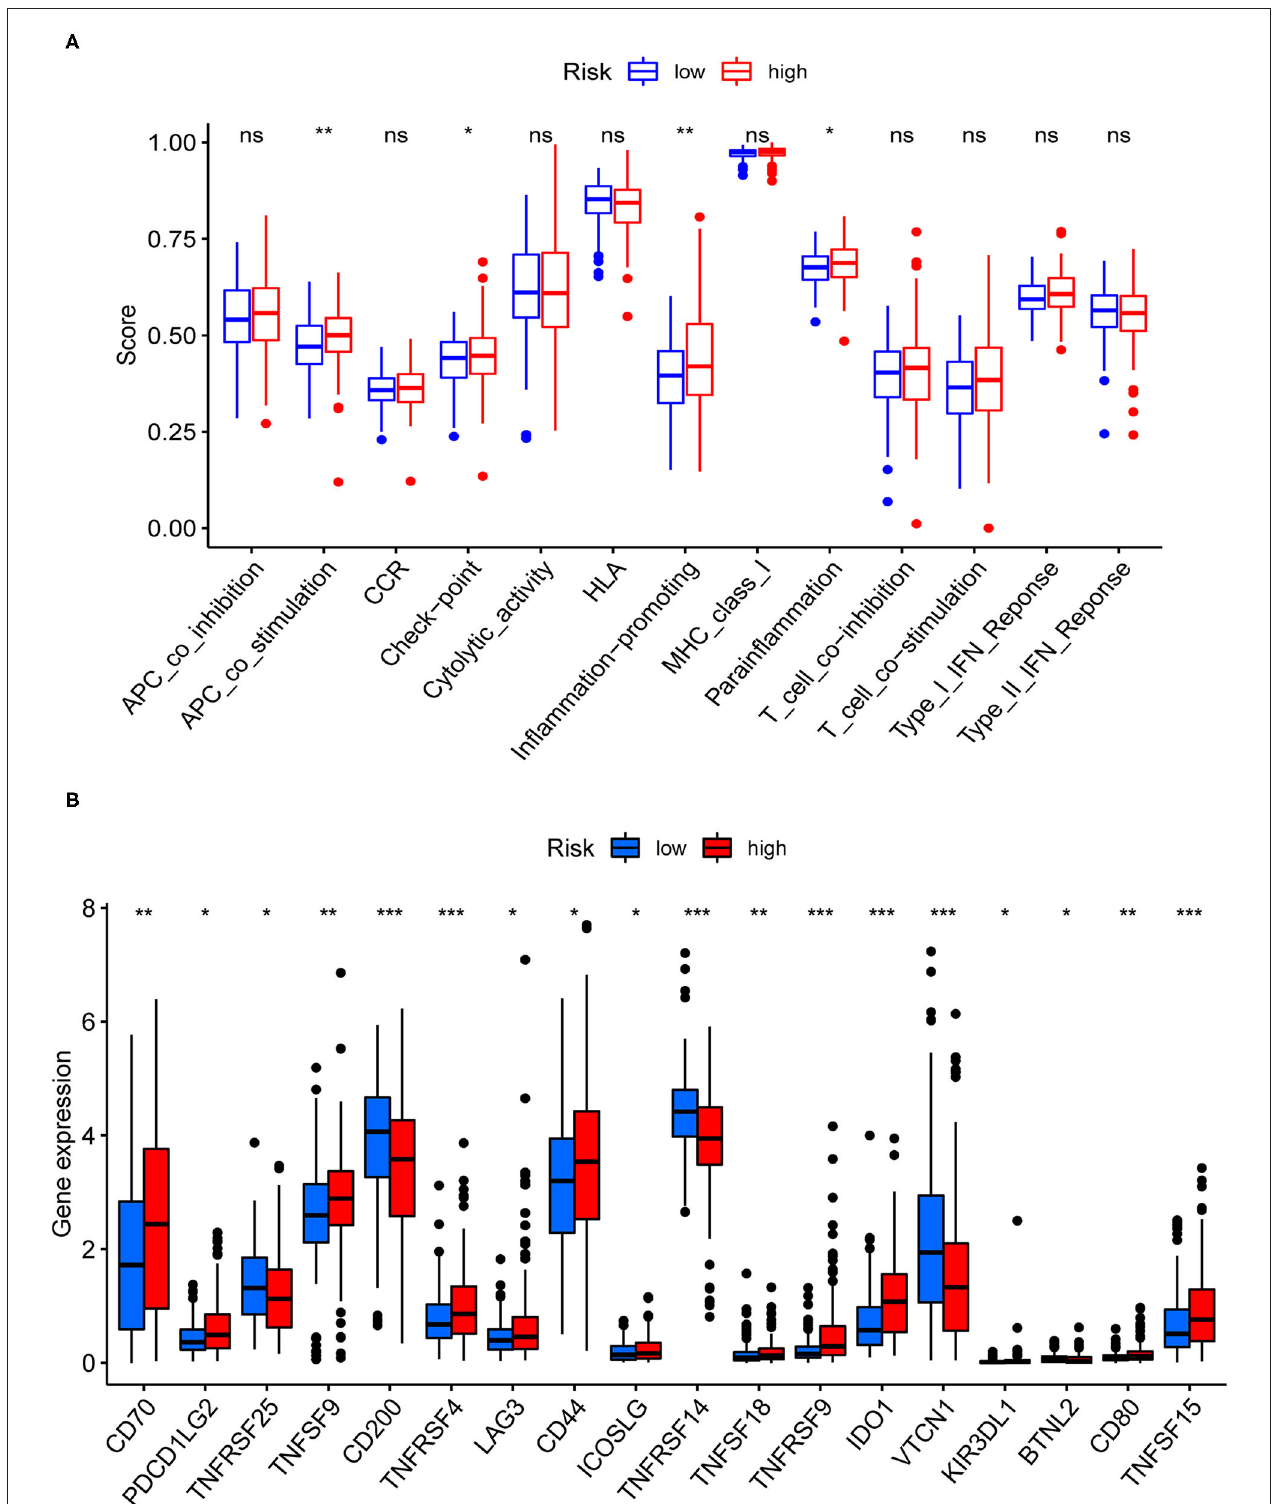
FIGURE 8 | Immune-related analyses for the patients with pRCC from TCGA. (A) Correlation analysis for immune cell subpopulations between the two pRCC groups. (B) The expression levels of immune checkpoint genes between the two pRCC groups. * p < 0.05; ** p < 0.01; *** p < 0.001; ns = non-significant.